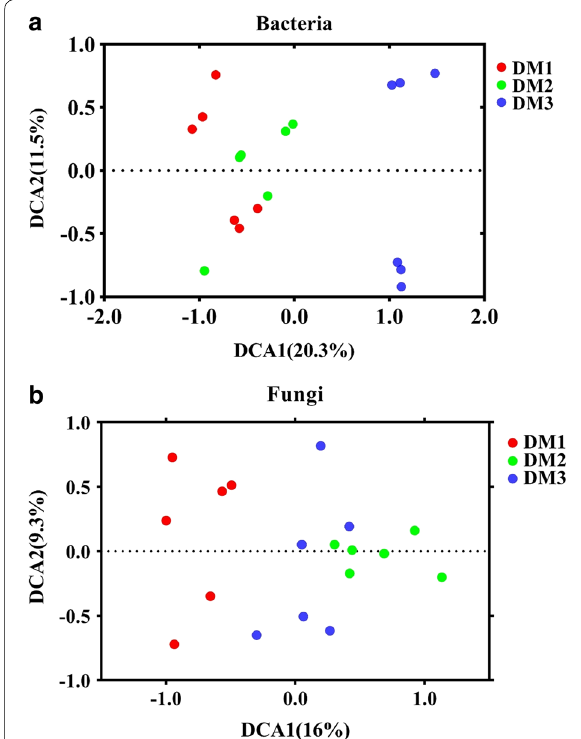
Fig. 2 Detrended correspondence analysis (DCA) under different disease severities. DM1, DM2 and DM3 represent the three disease severities of angular leaf‑spot of cucumber, respectively. DM1 symptomatic‑mild, DM2 symptomatic‑moderate, DM3 symptomatic‑severe